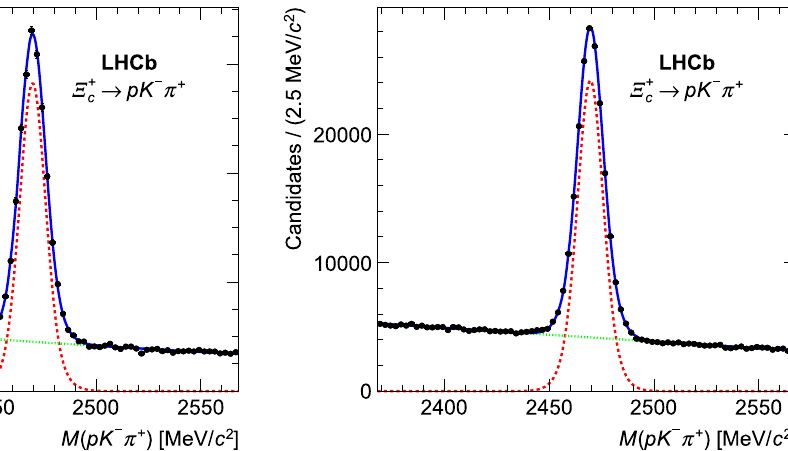
Fig. 2 Invariant-mass, M ( pK − π + ) ,distributionsofselected Ξ + c can- didates are shown in the (left) 2011 and (right) 2012 data samples. Data points are in black. The overlaid fitted model (blue continuous line) is a